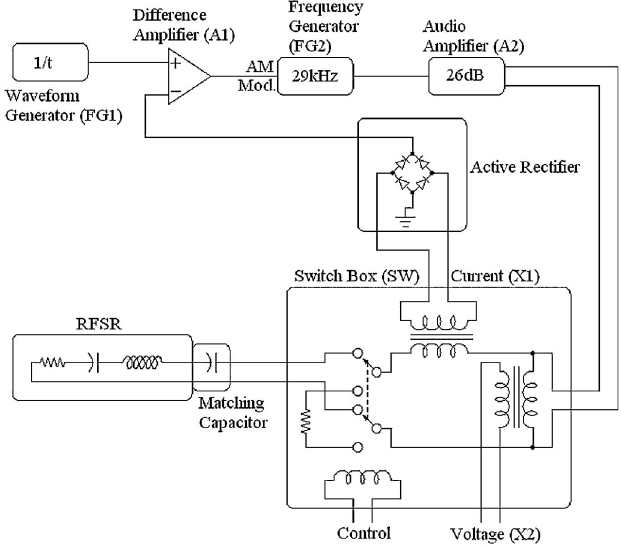
FIG. 3. Schematic of the control electronic circuit of the RFSR. An arbitrary waveform generator (FG1) sends a 1 =t ramp signal to a difference amplifier (A1). The amplifier outputs signal and the rectified the signal difference between the 1 =t tof 29 kHz feedback signal driven by the spin rotator coil. Current and voltage signals are measured by ADCs for each neutron pulse (see Fig.